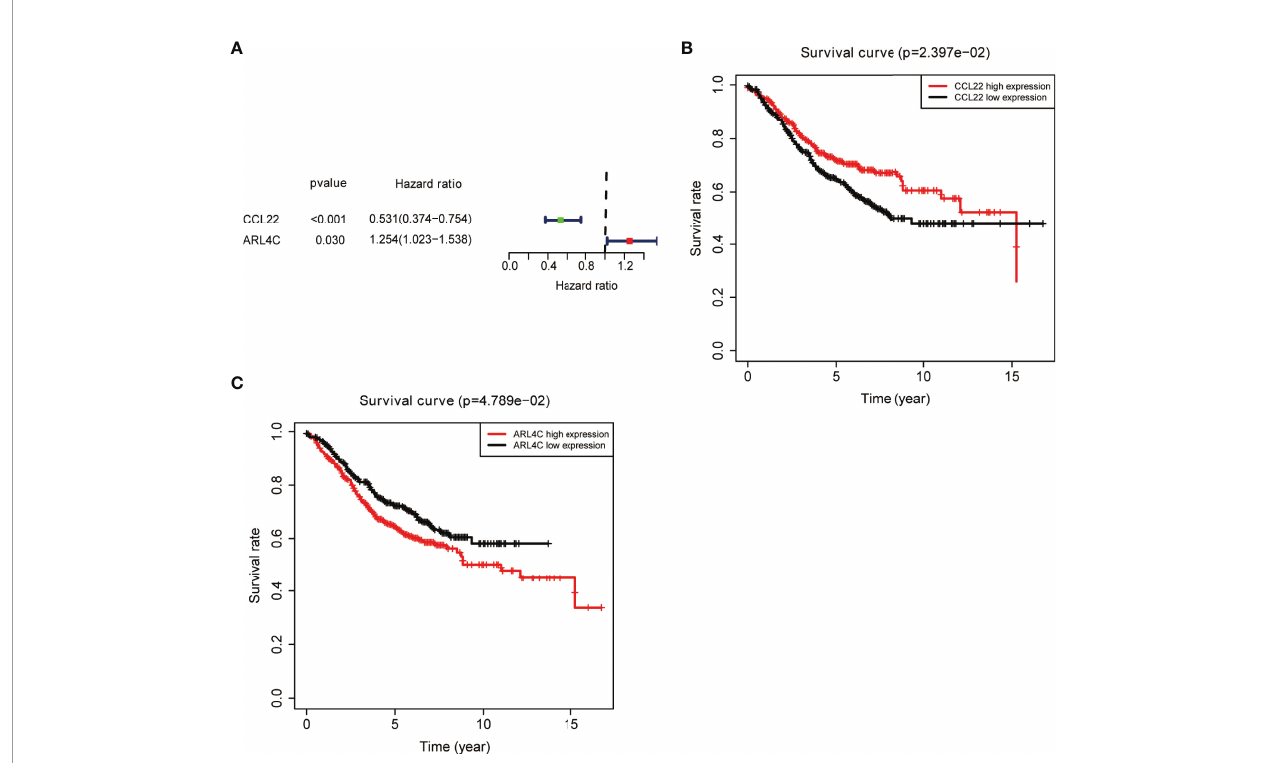
FIGURE 5 | External validation of key prognostic genes using the GEO database. (A) Forest plot of risk genes: Red represents high-risk genes (hazard ratios, HR > 1); green represents low-risk genes (HR < 1). (B, C) Overall survival between high and low CCL22 (B) and ARL4C (C) expression